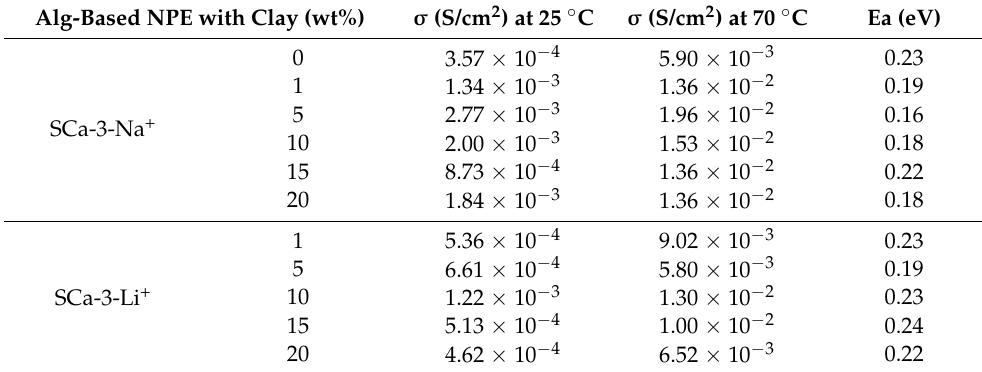
Table 2. Values of ionic conductivity ( σ ) and activation energy (Ea) of Alg-based NPEs with 0–20% of SCa-3-Na + and SCa-3-Li +